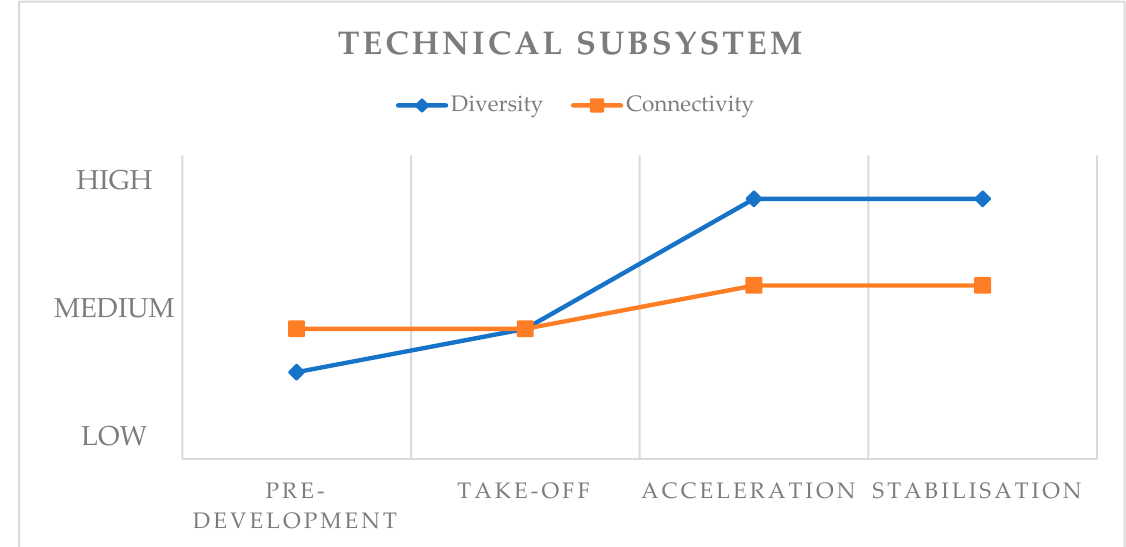
Figure 6. Development of diversity and connectivity measures in the technical subsystem.